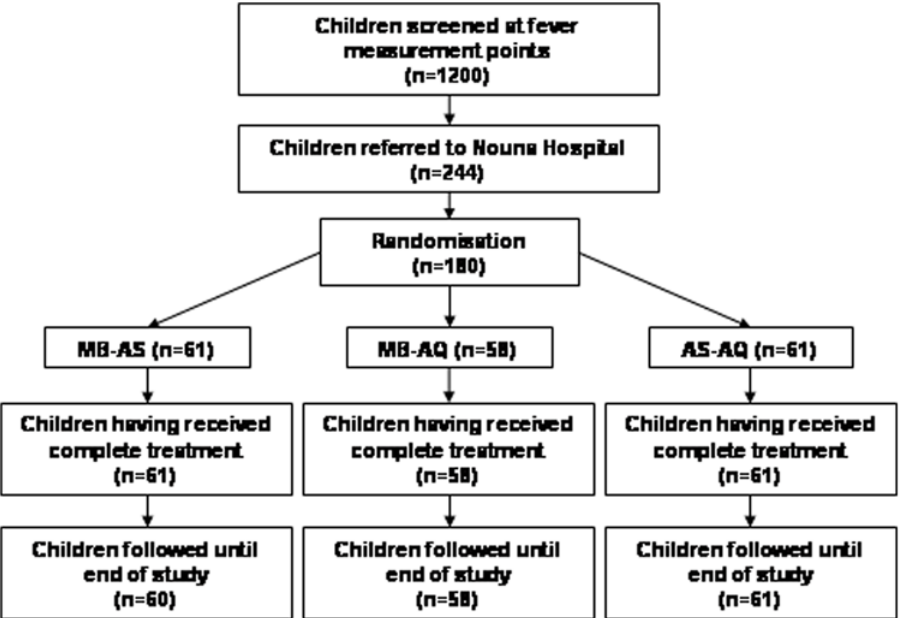
Figure 1. Flow chart of study patients.